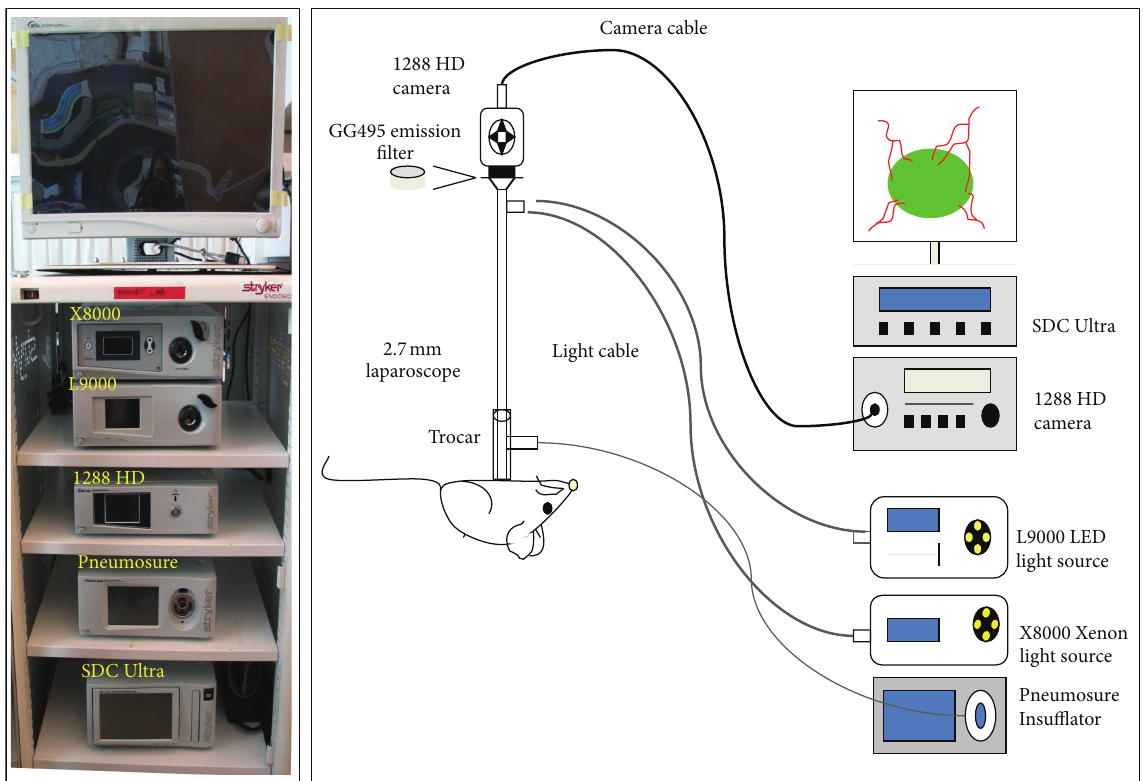
Figure 3: Stryker laparoscopic setup. A standard laparoscopic tower was slightly modified to achieve a fluorescence light mode that permitted detection of fluorescence signals while still allowing visualization of the background. The LED light source (Stryker L9000 LED lamp) was filtered through a glass emission filter (Schott GG495) that was placed between the laparoscope and the 1288 HD camera. With alterations to red, blue, and green components of the light source, we were able to visualize tumors of different fluorescent wavelengths. A Stryker X8000 Xenon light source was used for bright field laparoscopy